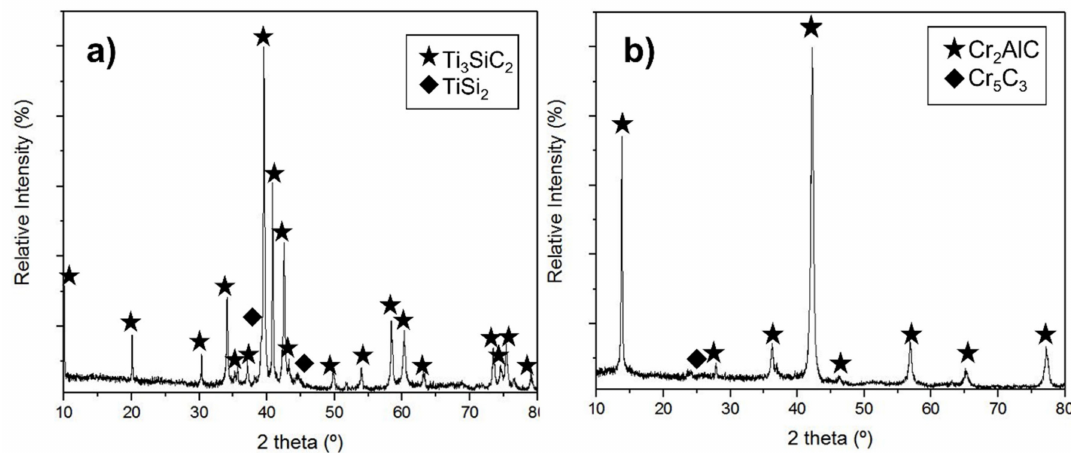
Figure 2. The X-Ray diffraction patterns of self-synthesized powders of ( a ) Ti 3 SiC 2 and ( b ) Cr 2 AlC MAX